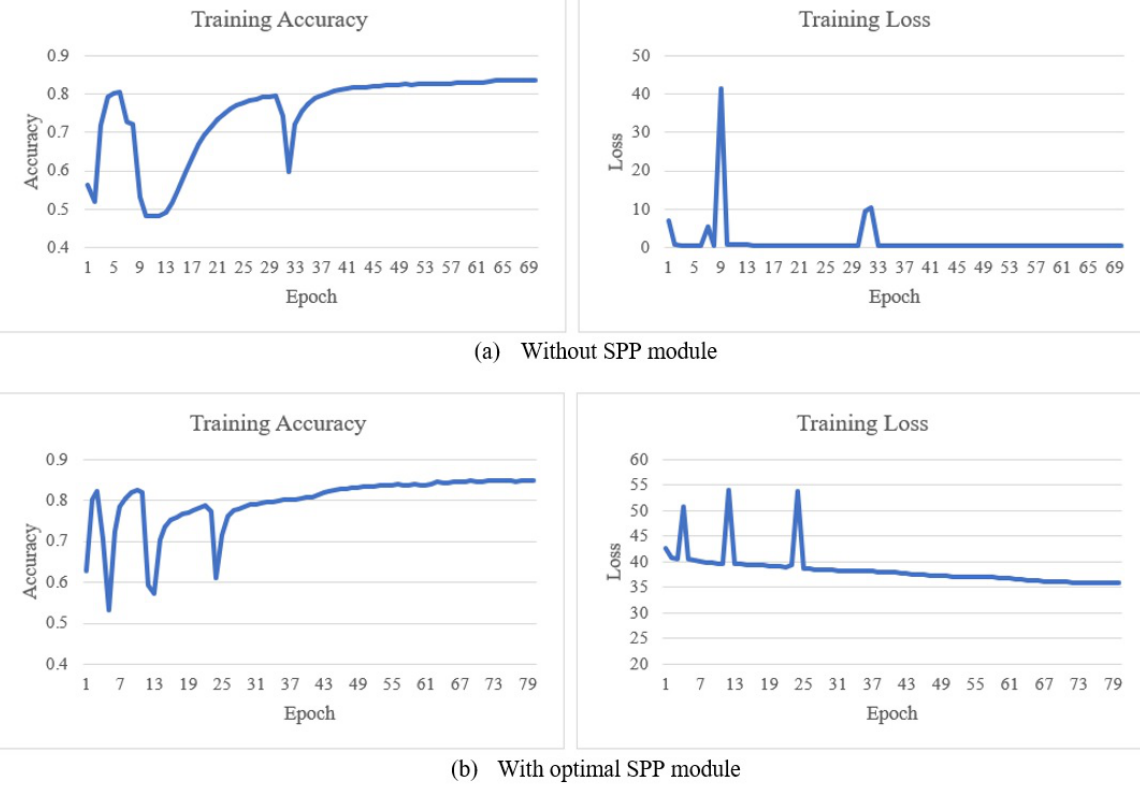
Figure 6. Training accuracy and loss of forest monitoring system using high-difficulty